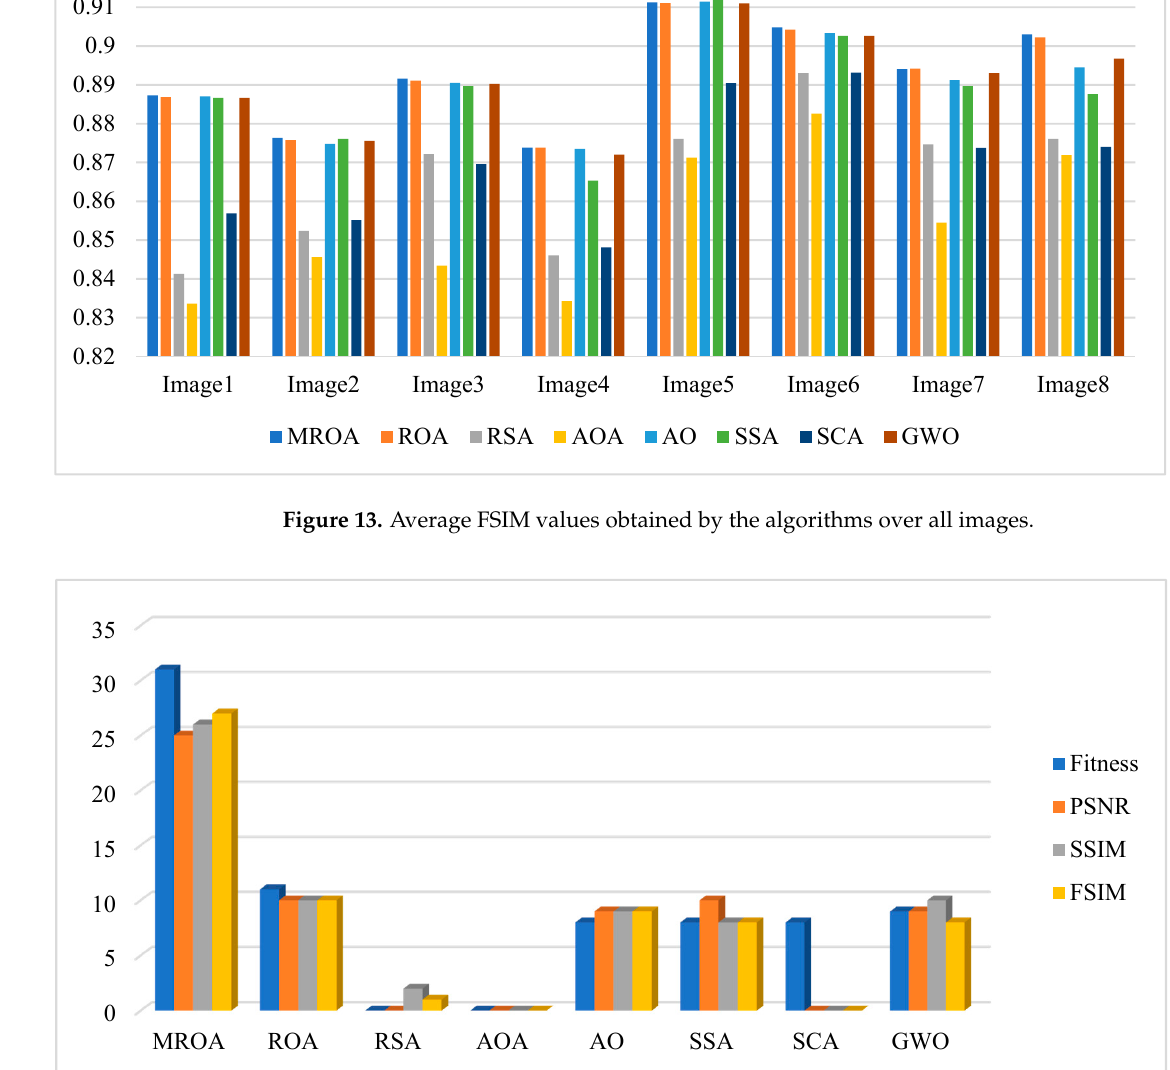
Figure 14. The number of best cases based on the fitness, PSNR , SSIM , FSIM obtained by algorithms over all images.